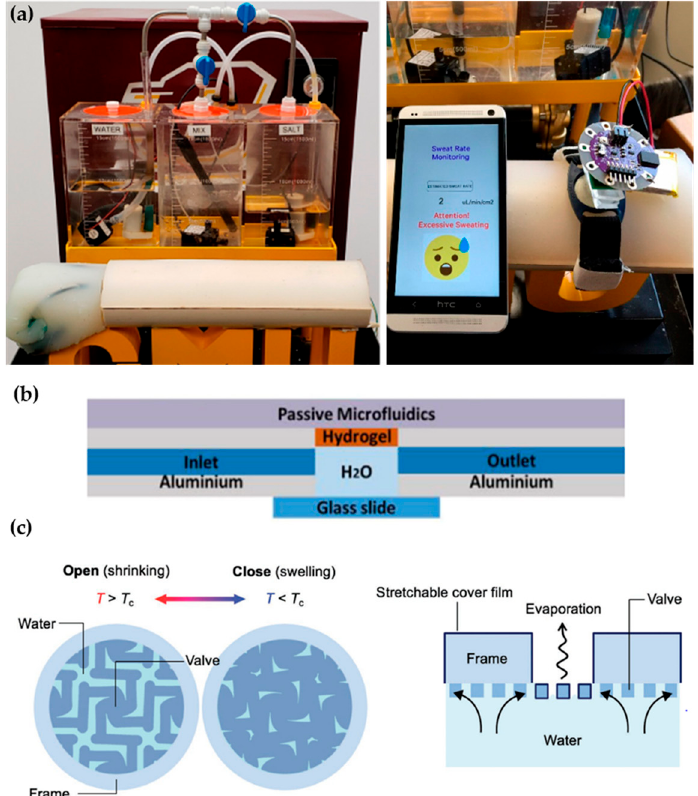
Figure 4. Alternative approaches for perspiration models. ( a ) Image of the sweating arm prototype developed by Brueck et al. [49] showing the arm mold and the fluid tanks for sweat solution (left). In vitro test with a wearable device that monitors sweat rate (right). Adapted with permission from [49]. Copyright 2019, MDPI. ( b ) Schematic cross-section of the artificial skin used by Garcia- Cordero et al. [52]. Adapted with permission from [52]. Copyright 2018, IEEE. ( c ) Schematic of the artificial perspiration membrane for heat dissipation developed by Kim et al. [53]. Adapted with permission from [53]. Copyright 2020, John Wiley and Sons.